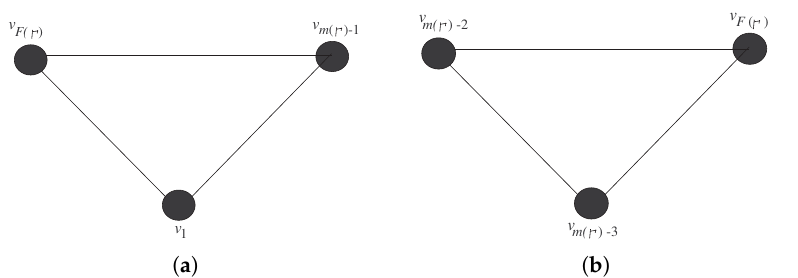
Figure 2. Induced subgraphs of g ( Γ ) for the cases ( a ) F ( Γ ) > m ( Γ ) − 1 and ( b ) F ( Γ ) = m ( Γ ) −